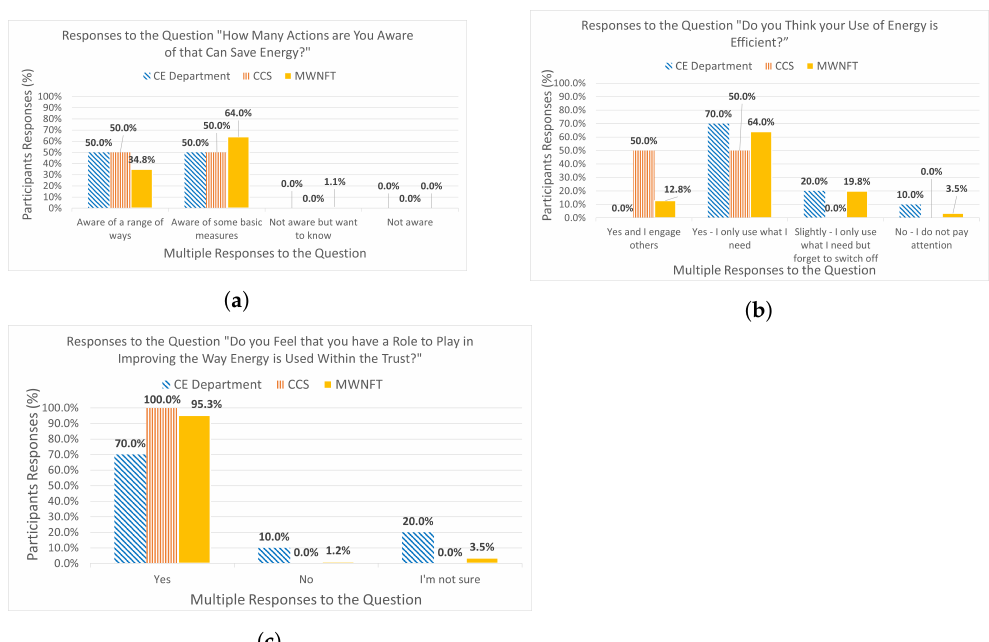
Figure 10. Participants’ responses to the selected questions from the “Views and Ideas on Energy Usage and Behaviour” questionnaire; ( a ) Q: “How Many Actions are You Aware of that Can Save Energy?”, ( b ) Q: “Do you Think your Use of Energy is Efficient?”, ( c ) Q: “Do you Feel that you have a Role to Play in Improving the Way Energy is Used Within the